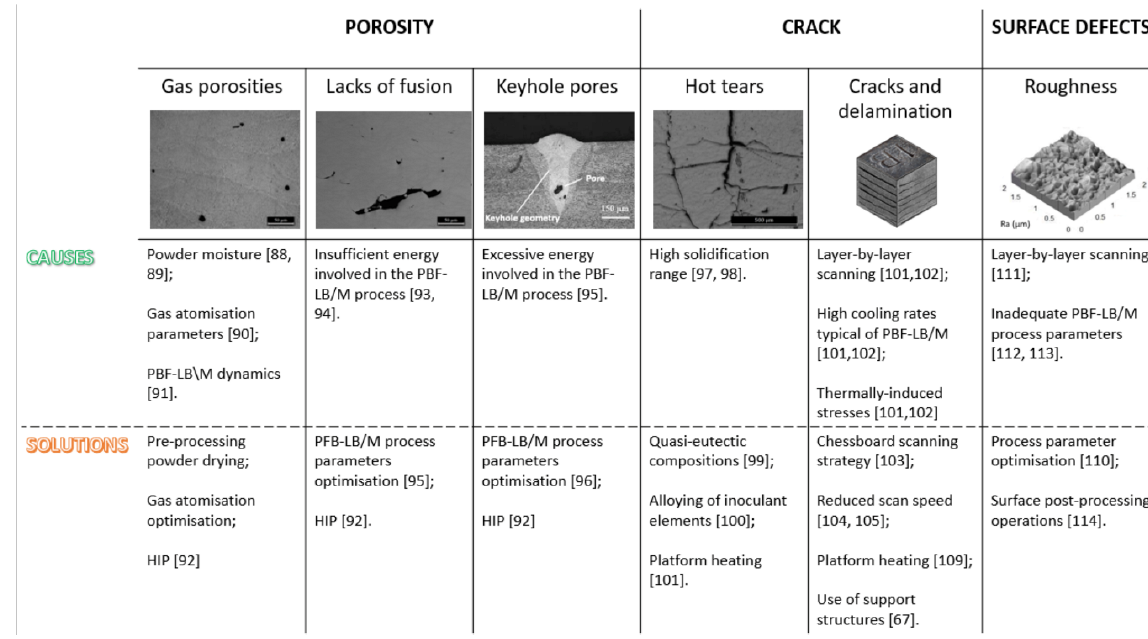
Figure 8. Causes and solutions in the formation of the main defects in the PBF-LB/M process according to the